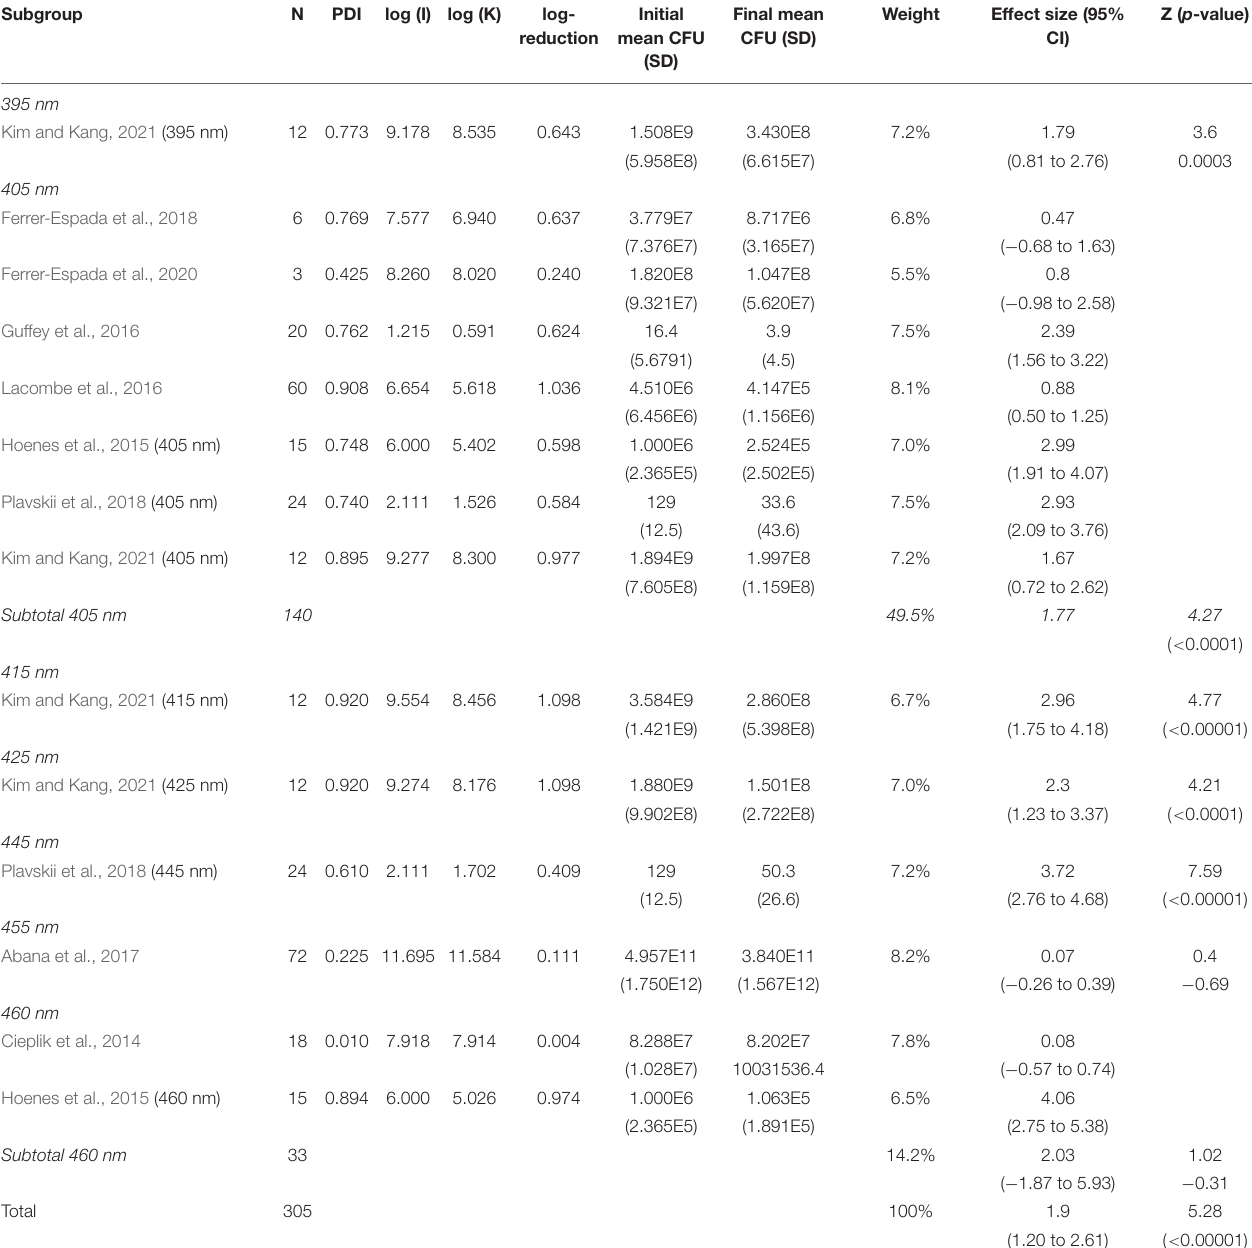
TABLE 4 | CFU E. coli outcomes by wavelength.